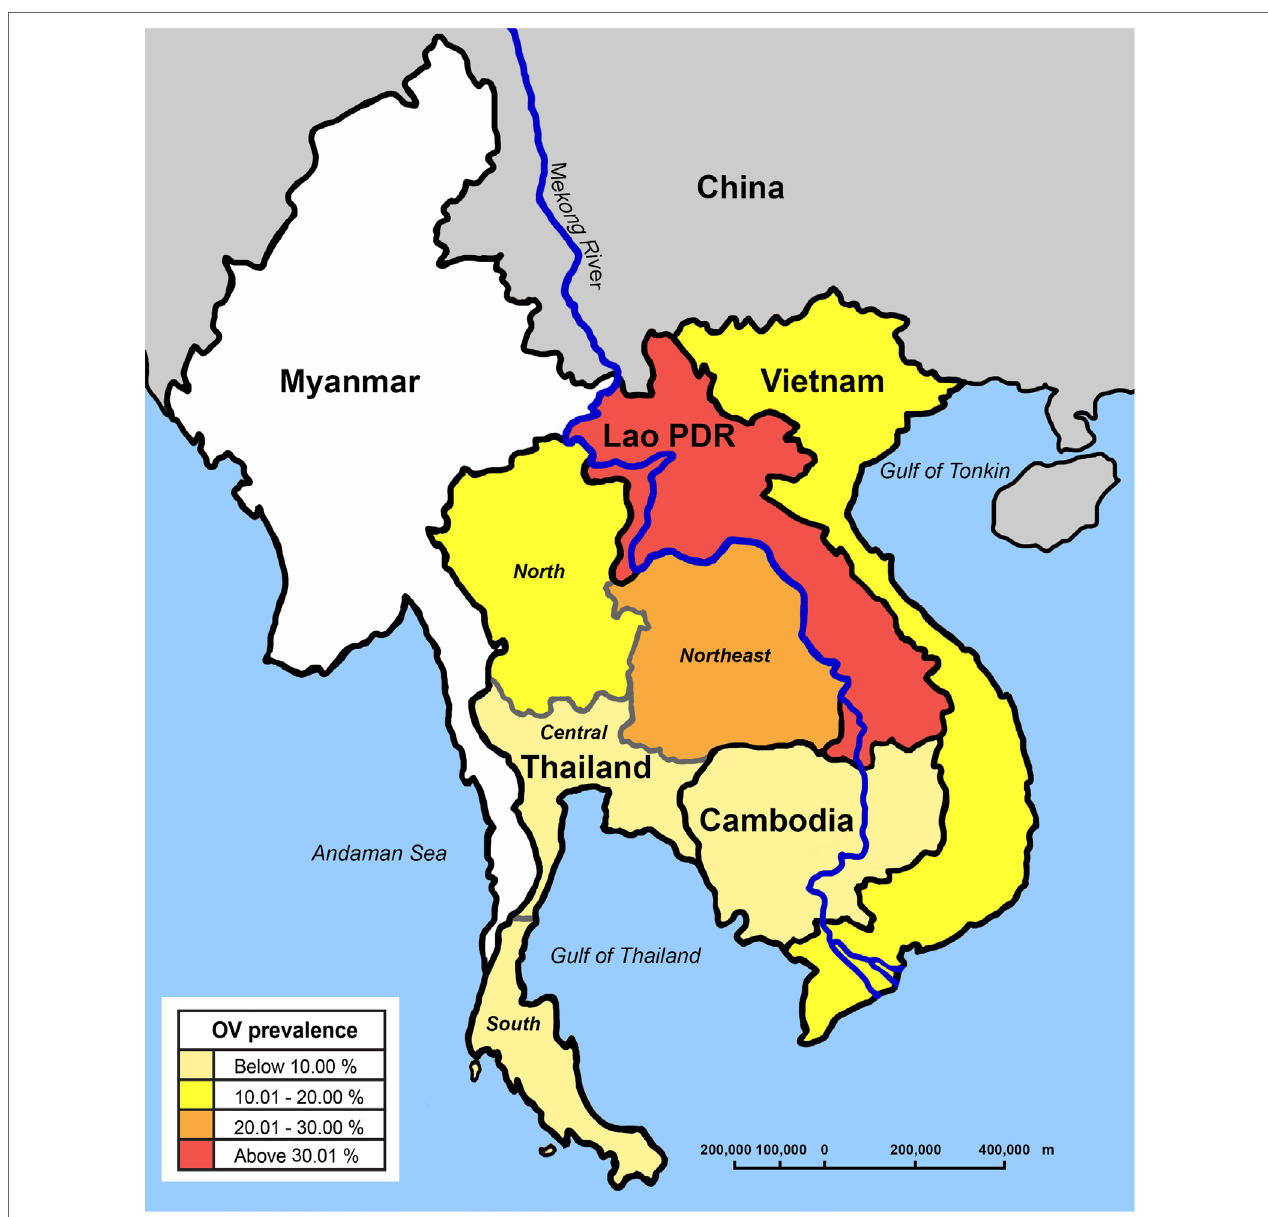
FigURe 1 | Distribution of Opisthorchis viverrini (OV) in Southeast Asia.